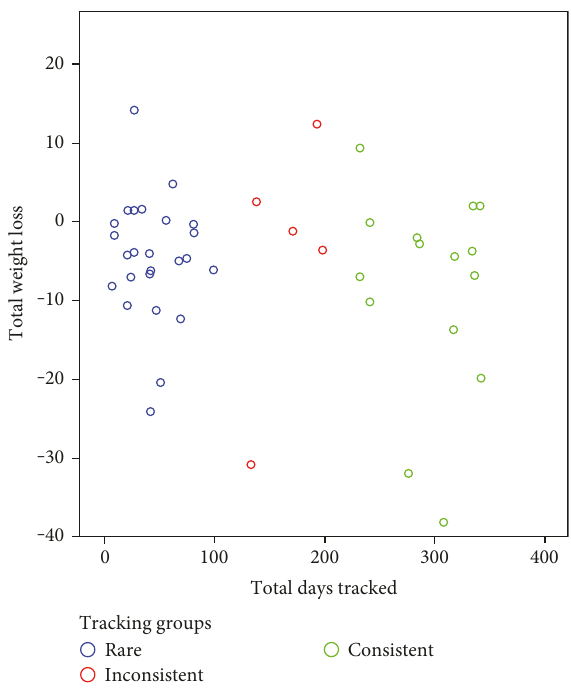
Figure 2: A scatterplot of total days tracked by total weight loss in pounds per